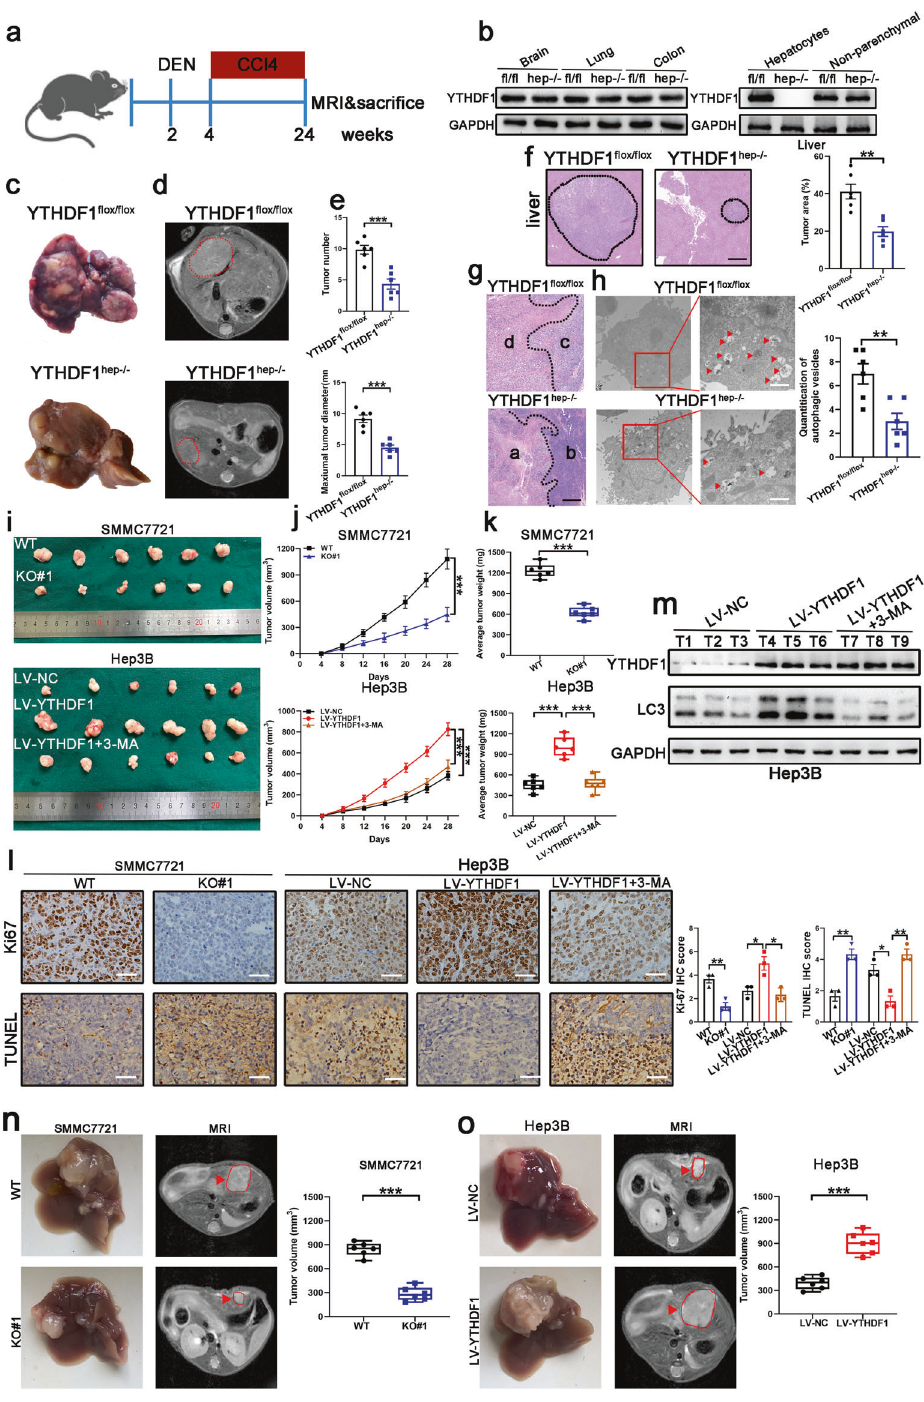
Fig. 4 YTHDF1 de fi ciency inhibits HCC growth. a Schematic representation of the DEN/CCl4-induced HCC model. b YTHDF1 expression in hepatocytes and nonparenchymal cells of YTHDF1 hep − / − and YTHDF1 fl ox/ fl ox mice by western blotting. c – e Representative gross appearance ( c ), magnetic resonance imaging (MRI) ( d ), tumor number, and maximum tumor diameter ( e ) of livers from DEN/CCl4-treated YTHDF1 hep − / − and YTHDF1 fl ox/ fl ox mice. f Hematoxylin and eosin (H&E) staining of liver sections from DEN/CCl4-treated YTHDF1 hep − / − and YTHDF1 fl ox/ fl ox mice. Scale bar, 200 µm. g H&E staining for representative tumor sections. Scale bar, 200 µm. h TEM showing the ultra-microstructure of the tumor section. Red arrows indicate autophagosomes or autolysosomes that have a double-layer structure. Scale bar, 1 µm. i Representative xenograft tumors after subcutaneous injection of SMMC7721 cells transfected with YTHDF1-KO#1 and WT 28 d after inoculation (upper). Representative xenograft tumors after subcutaneous injection of Hep3B cells transfected with LV-YTHDF1 and corresponding control 28 d after inoculation (low). 3-MA was used as an autophagy inhibitor. j Time course of HCC xenograft growth. k Tumor weight of HCC xenografts. l Proliferation (Ki67) and apoptosis (Tunel) immunohistochemistry (IHC) staining of tumor sections. Scale bar, 100 µm. m Western blotting of YTHDF1 and LC3 proteins. 3-MA was used as an autophagy inhibitor. n Nude mice orthotopically implanted tumors of YTHDF1-knockout SMMC7721 cells. o Nude mice orthotopically implanted tumors of YTHDF1-overexpressing Hep3B cells. Error bars represent the mean ± SEM and the dots represent the value of each experiment; * P < 0.05, ** P < 0.01, *** P <